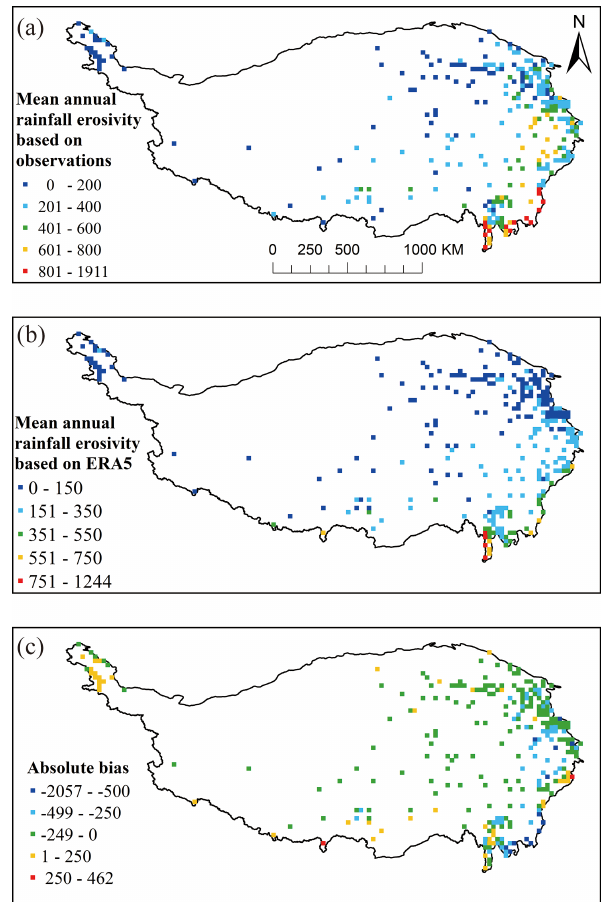
Figure 6. Mean annual rainfall erosivity in 2013–2020 (excluding 2017) based on (a) in situ precipitation observations and (b) ERA5 reanalysis precipitation data. (c) Absolute bias between the val- ues based on ERA5 reanalysis data and precipitation observations. Unit:MJmmha − 1 h − 1 yr − 1